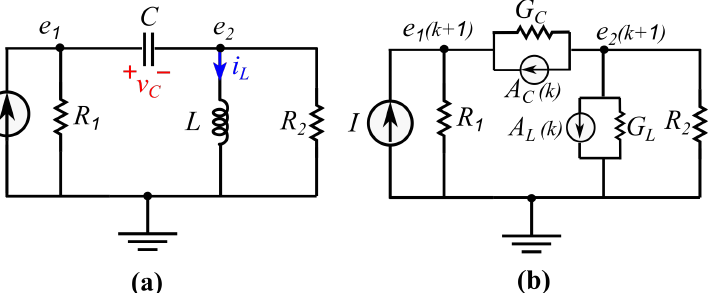
Figure 8. ( a ) Diagram of the system under study. ( b ) DC-equivalent representation of the system under study obtained by using the resistive companion as simulation approach and the trapezoidal rule as the numerical integration method, according to which the DC-equivalent circuits of the capacitor and the inductor are given by parallel combinations of an ideal current source A and a conductance G .